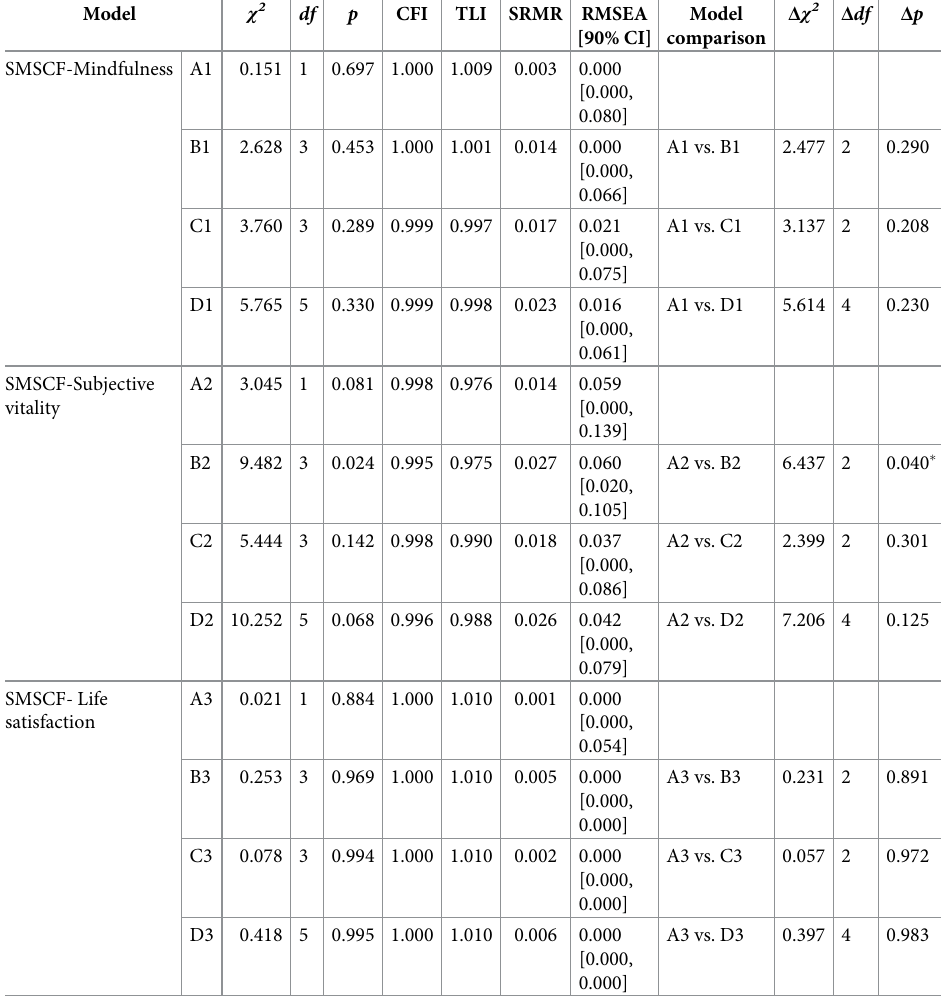
SMSCF = Social media self-control failure, Model A: unconstrained model, Model B: constrained the